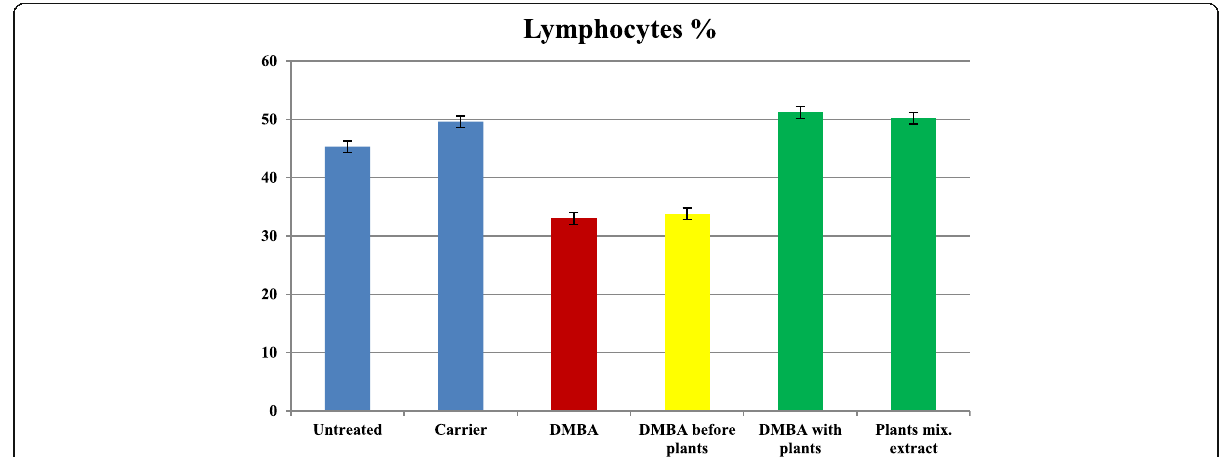
Fig. 3 Lymphocyte percentage in the different rat groups. Standard errors are indicated on the bars and the significance levels are shown in Table